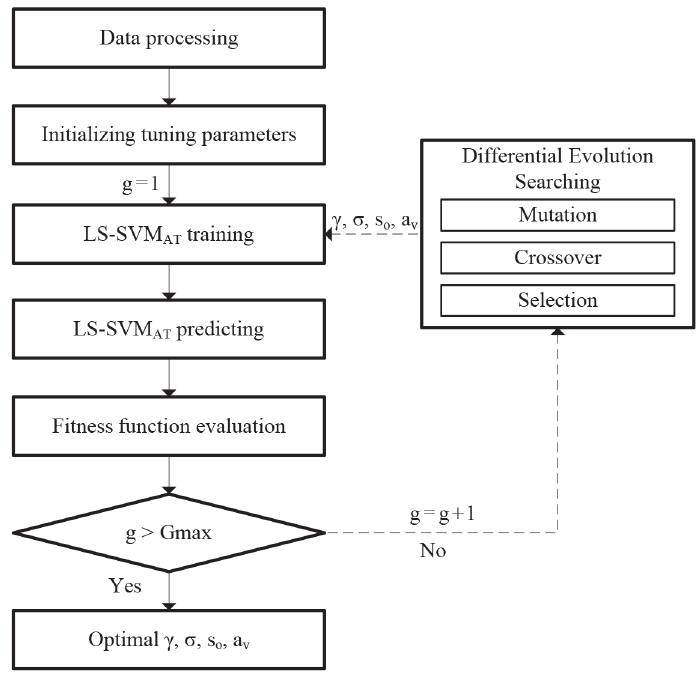
Fig. 3. Differential Evolution based cross-validation